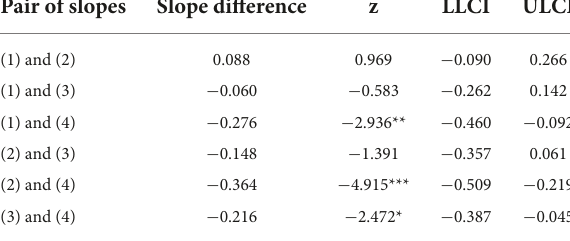
( b = − 0.364, p < 0.001). The last indicated a significant slope difference in the interpersonal sensitivity-depression link between high and low family support for low PsyCap freshmen ( b = − 0.216, p = 0.014). In summary, familial